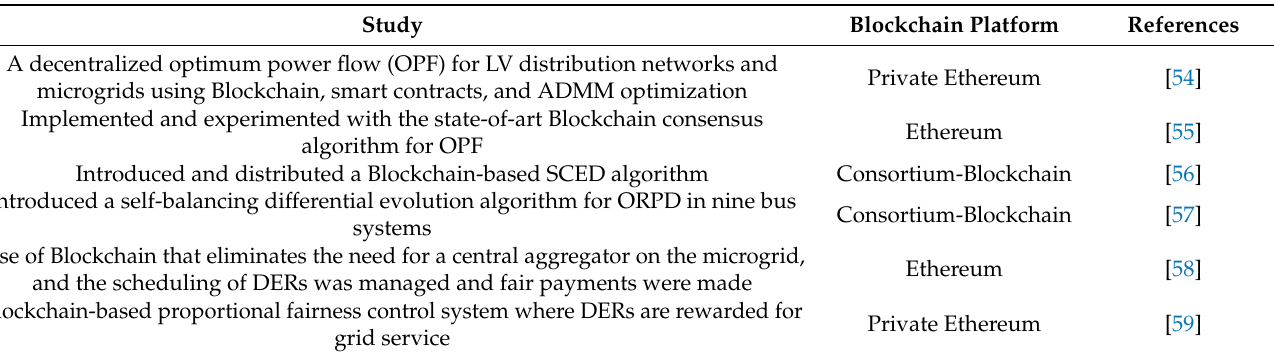
Table 4. Summary of publications employing Blockchain technology for power flow studies.